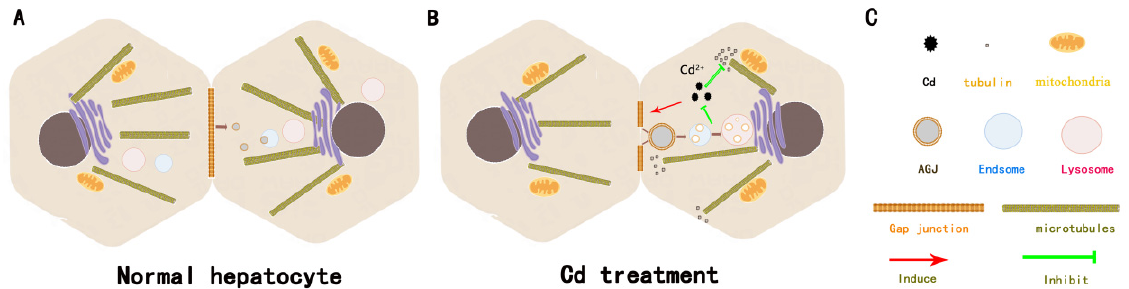
Figure 6. Alleviation of Cd-induced toxicity in rat hepatocytes through the formation of AGJs and degradation via endosome–lysosome pathway: ( A ) Small-scale degradation of Cx43 in normal cells; ( B ) Internalization of Cx43 into large AGJs by hepatocytes. The AGJs can fuse with early endosomes, develop into late endosomes, and finally fuse with lysosomes. Internalization of Cx43 attenuates Cd-induced cell damage and apoptosis through an unknown pathway. ( C ) Explanation of symbols and patterns in Figure ( A ) and ( B